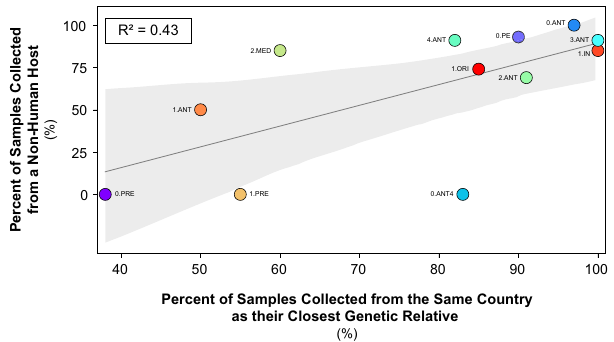
Fig. 5 Association between host and country of origin. Linear regression of host associations. A linear regression of host-associations on the degree of geographic structure at the country